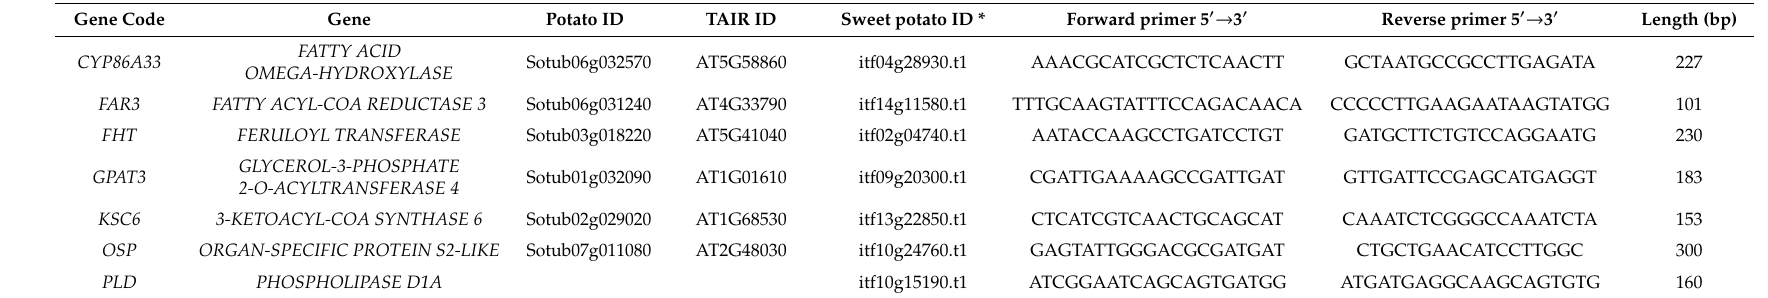
Table 2. Sweet potato primers for periderm- and suberin-related genes based on their alignment to potato and Arabidopsis orthologs. Gene